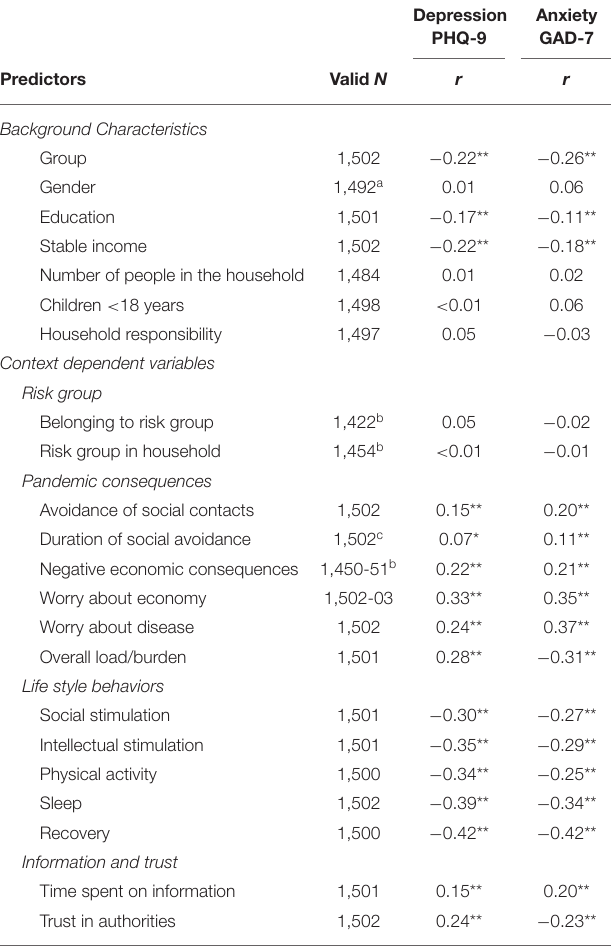
TABLE 5 | Significant Pearson’s correlations between outcomes and